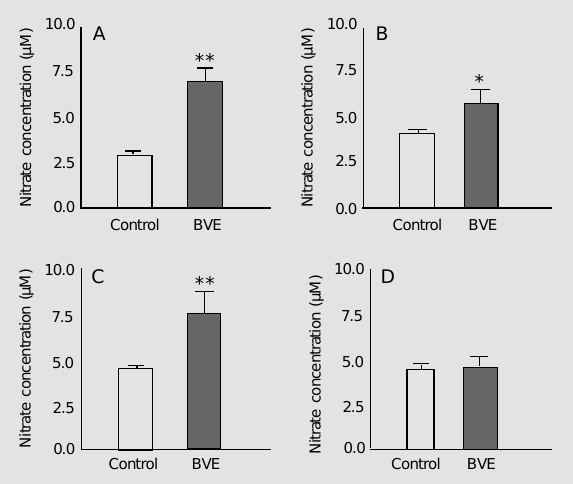
Figure 3. Effect of hypertonic (0.3 M NaCl) blood volume expansion (BVE) on nitrate content of medial basal hypothalamus (A), neural lobe (B), adenohypophysis (C) and median eminence (D). Data are reported as means ± SEM for 7-10 rats, before (control) and 5 min after BVE. *P<0.01 and **P<0.001 compared to control (Student t